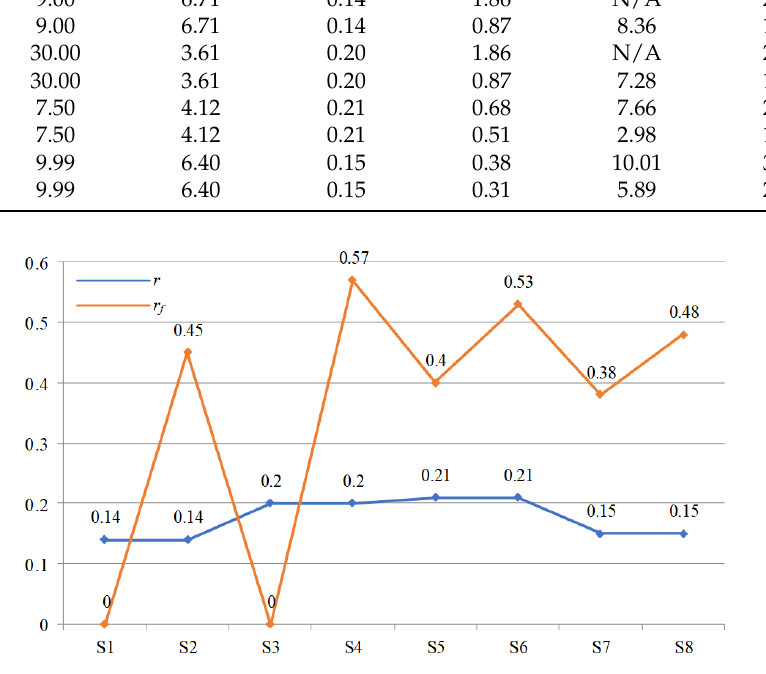
Figure 11. Ship collision risk index line chart based on r and r f